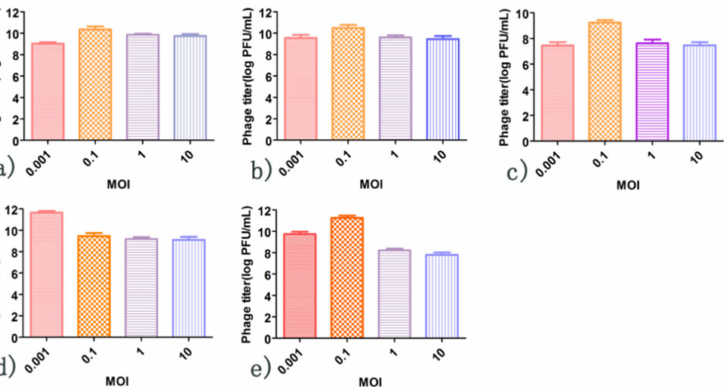
Figure 3. The optimal multiplicity of infection of S. aureus phages isolated from clinical mastitis. When the MOI was 0.1, the titers of phages 4086-1, 4086-2, 4086-3, and 4086-6 were the highest, which were 1.46 × 10 10 PFU/mL, 3.21 × 10 10 PFU/mL, 7.66 × 10 10 PFU/mL, and 2.35 × 10 11 PFU/mL, respectively. While the MOI was 0.001, the titer of phage 4086-4 was the highest at 2.41 × 10 12 PFU/mL. ( a ) Phage 4086-1; ( b ) Phage 4086-2; ( c ) Phage 4086-3; ( d ) Phage 4086-4;